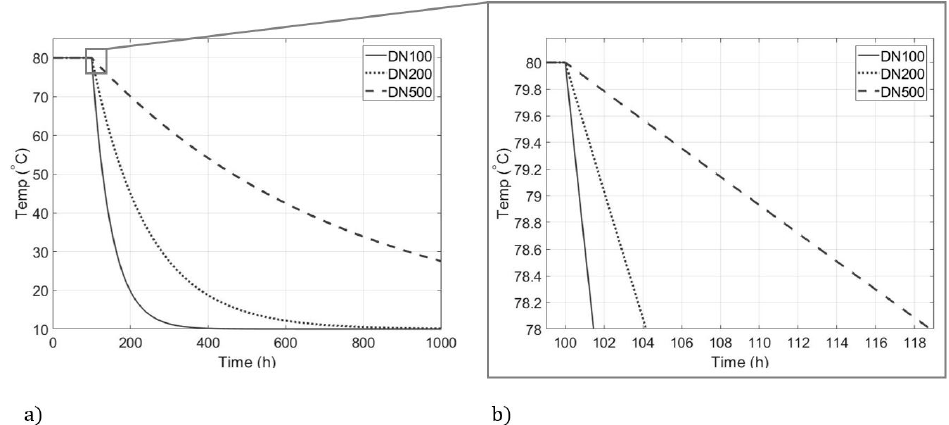
Figure 3. ( a ) Expected cooling times for pipes of different dimensions; ( b ) close-up of expected temperature declines during a shutdown; MATLAB model according to Section 2.1.1, T s fixed at 10 °C.